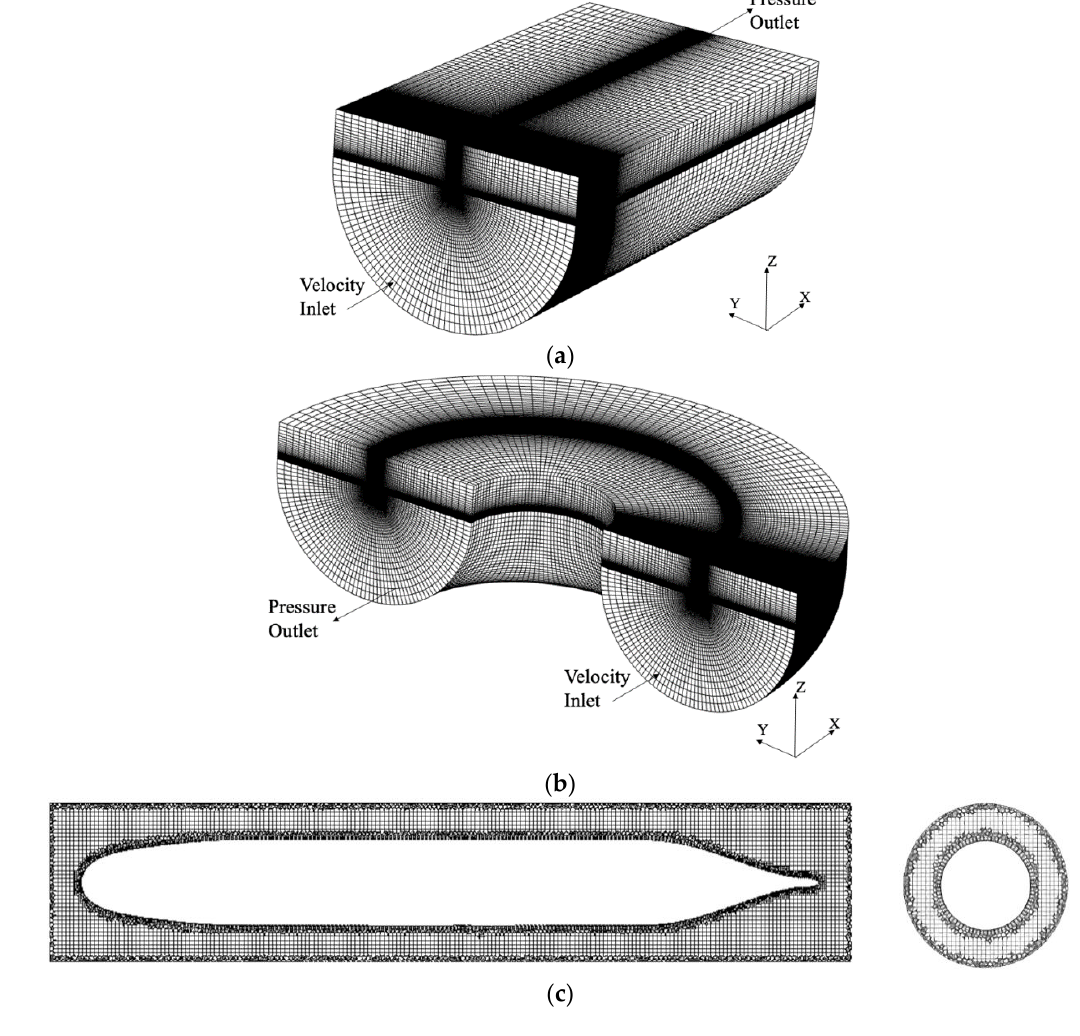
Figure 2. Initial grids of the computational domain. ( a ) Straight navigation. ( b ) Steady turning motion, ( c ) Overset region section profile.